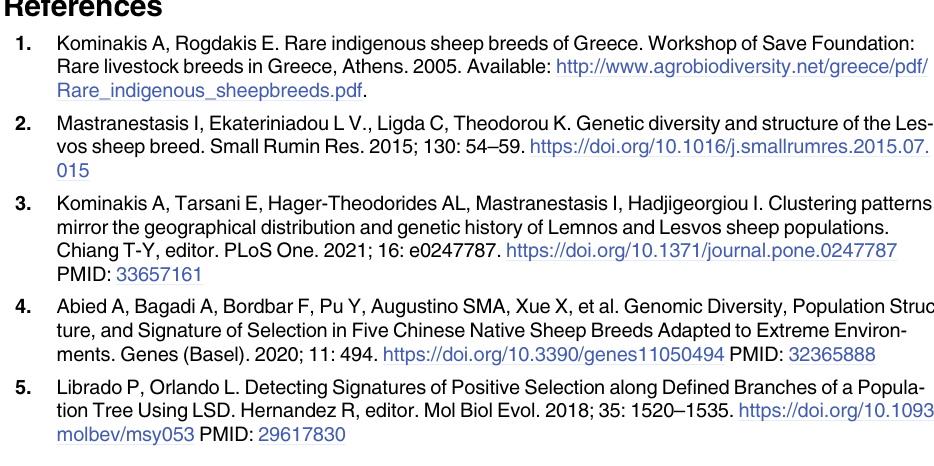
S2 Fig. Quantile- quantile (Q-Q) plot of GWAS results for the two origins (island vs. main- land). Blue dots denote the − log (p-value) obtained from the single locus mixed model and 10 the red line represents the expected values for the null hypothesis under no association. S1 Table. Distribution of samples per origin and region within origin (n: Number of sam- ples per region). S2 Table. Results by Gene Ontology biological process (GO BP) enrichment